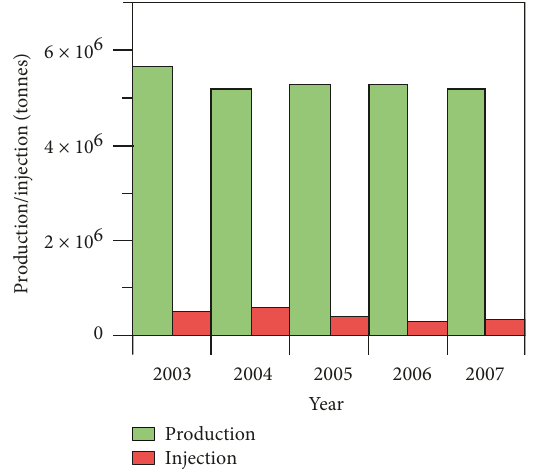
Figure 2: Yearly production and injection rates at the LHGF between 2003 and 2007.